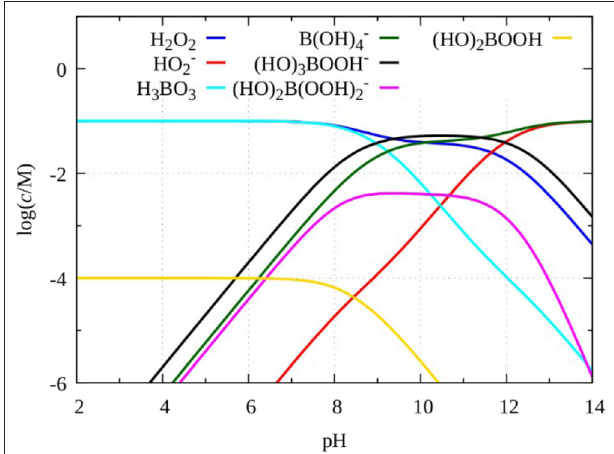
FIGURE 4 | Species distribution in a mixture of 0.1 mol/dm 3 boric acid and 0.1 mol/dm 3 H 2 O 2 calculated by using reactions R4, R5, R9, R10, R11, and R16.